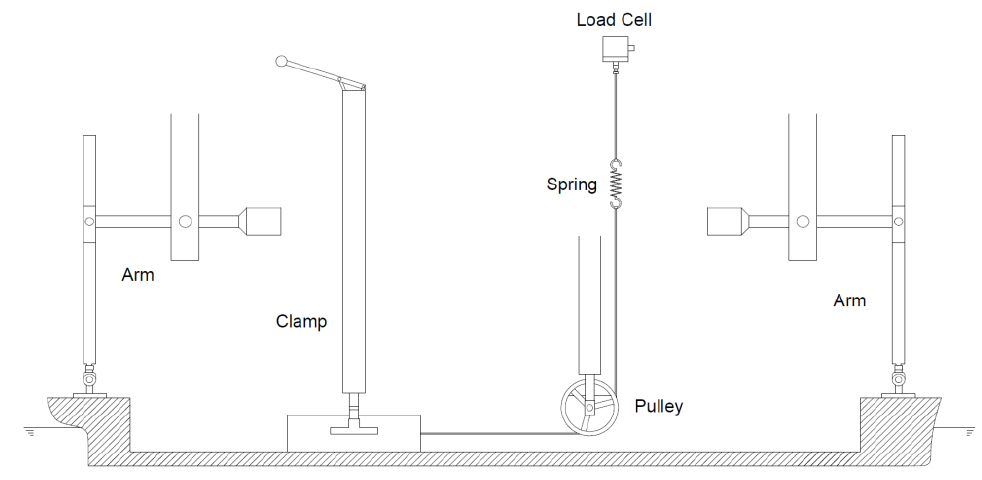
Figure 2. Towing tests setup sketch.